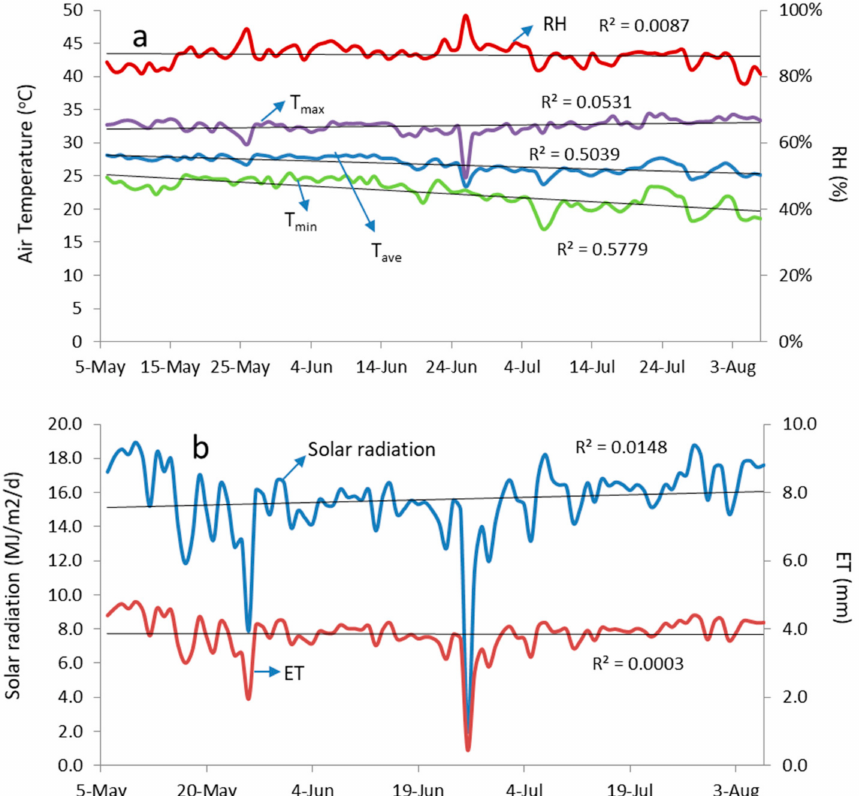
Figure 5. Weather condition during experiment: ( a ) air temperature and RH, ( b ) solar radiation and reference evapotranspiration